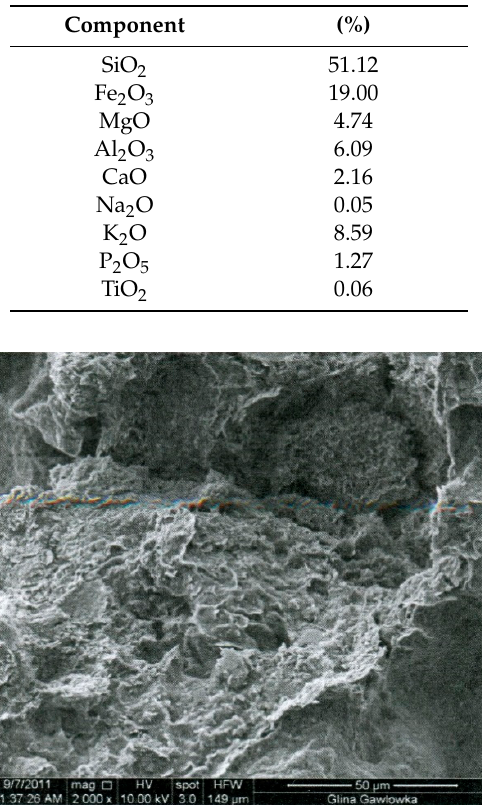
Table 2. Chemical composition of glauconite clay used in the investigation [49].